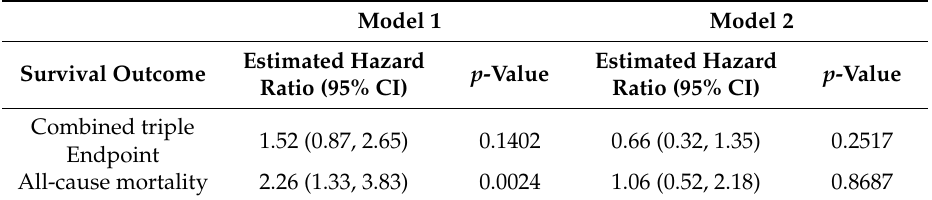
Table 3. Multivariable Cox regression for log (PYY).